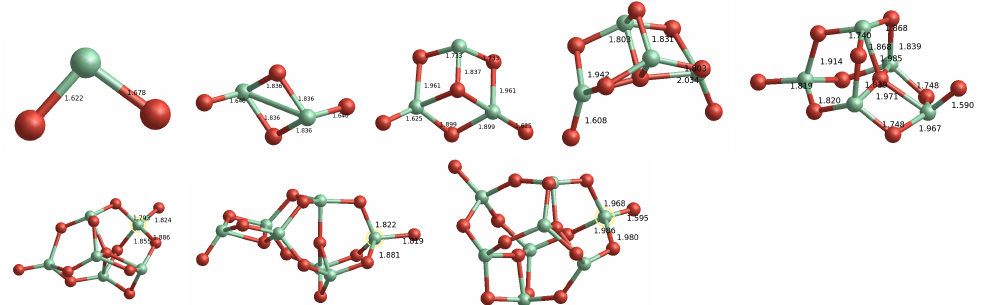
Figure 5. The adiabatically optimized structures of (TiO 2 ) n cations. Ti atoms are in olive; O atoms in red; numbers correspond to bond distances in